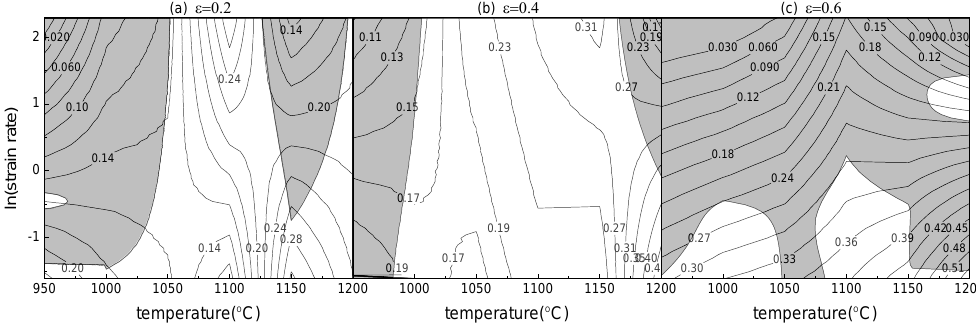
Figure 5. Hot processing maps at different strains of BSTMUF601 super-alloy. ( a ) The strain is 0.2; ( b ) the strain is 0.4; and ( c ) the strain is 0.6.